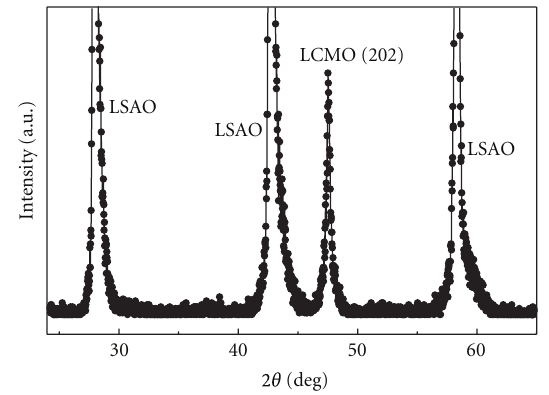
Figure 2: XRD pattern of LCMO/LSAO